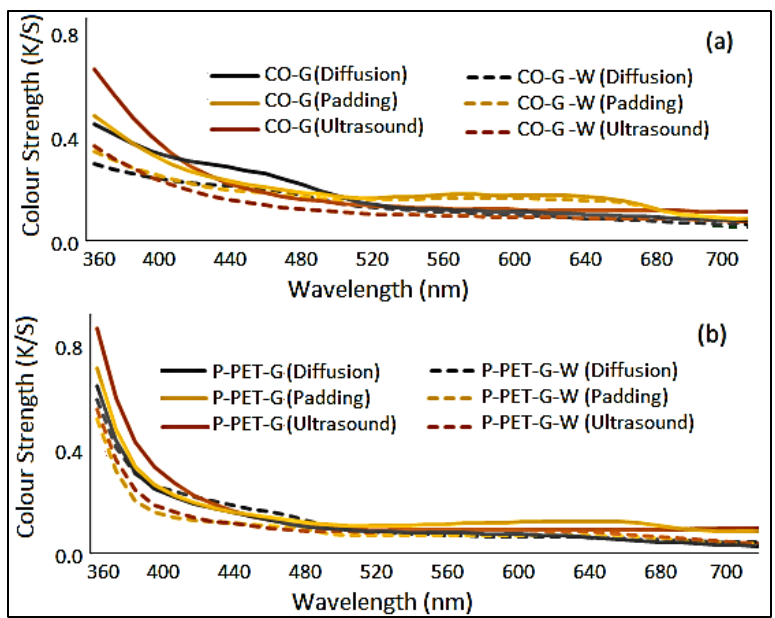
Figure 9. Effect of washing cycles on the color strength of cotton ( a ) and polyester ( b ) fabrics treated with geranium essential oil by different treatments.